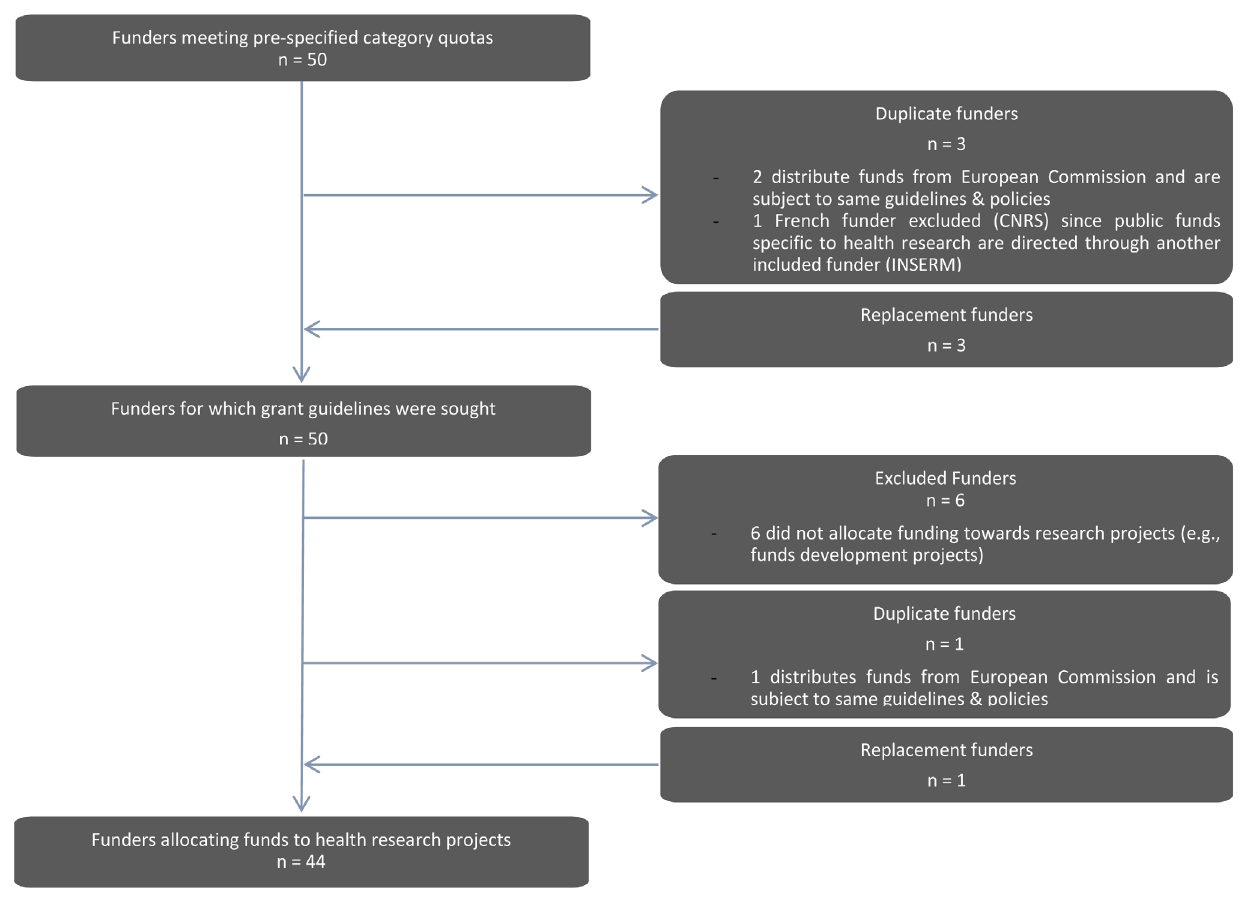
Figure 1. Flow diagram for selection of included